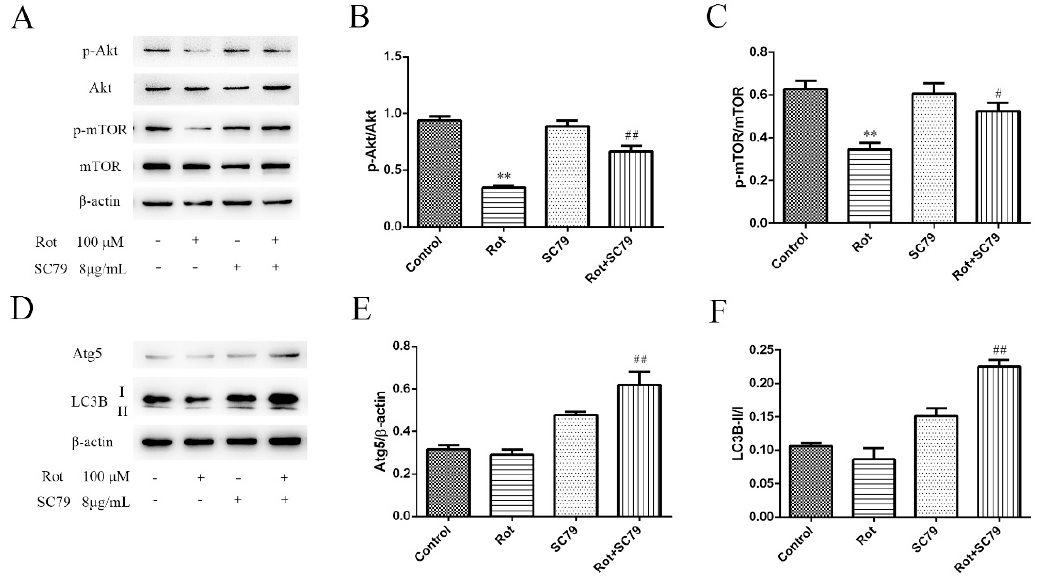
Figure 4. Western bolt validation of inactivated Akt / mTOR signaling and autophagy-related proteins in rotenone-injured SH-SY5Y cells. ( A ) SH-SY5Y cells were incubated with rotenone for 30 min, and then both phosphorylated and total Akt and mTOR were detected by western blot analysis. Here, 8 µ g / mL SC79 was applied to activate the Akt pathway, and β -actin served as the internal control. ( B , C ) A quantification of phosphorylated protein expressions, measured in Panel A. Data are expressed as the ratio of phosphorylated proteins to total proteins. ** p < 0.01 versus control group; # p < 0.05, ## p < 0.01 versus rotenone group ( n = 3). ( D ) The protein expression of Atg5 and LC-3B in rotenone-injured SH-SY5Y cells was examined by western blot. ( E ) A quantification of Atg5 expression. The data are expressed as the ratio of Atg5 to β -actin. ## p < 0.01 versus rotenone group ( n = 3). ( F ) A quantification of LC3B expression. The data are expressed as the ratio of LC3B-II to LC3B-I. ## p < 0.01 versus rotenone group ( n = 3).